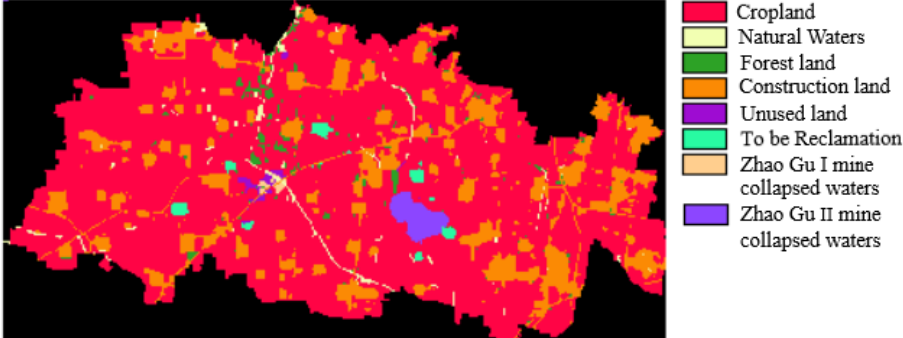
Figure 5. Simulation map of the spatial distribution pattern of landscape types in 2019.